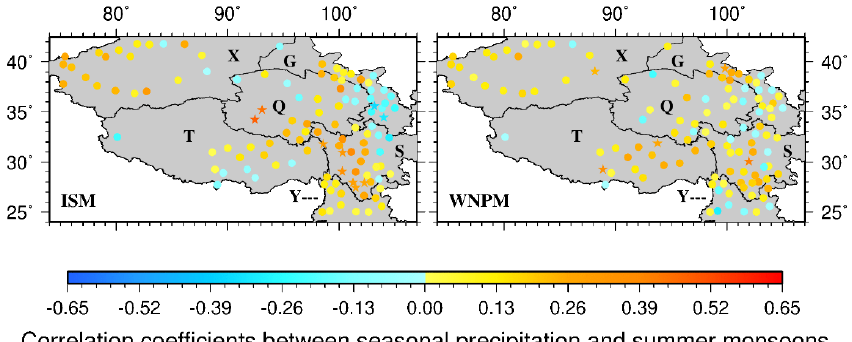
Figure 8. Spatial distributions of correlation coefficients between seasonal precipitation and sum- mer monsoon. Stars represent statistically significant trends ( p < 0.05). Open circles denote zero correlations. The same notation applies in the following figures as well.